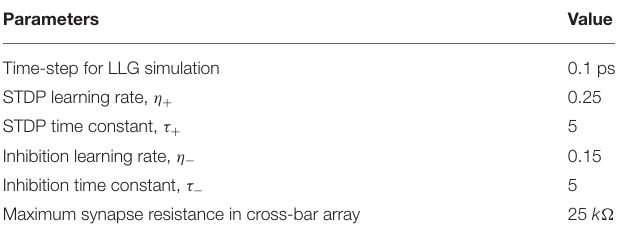
TABLE 2 | Learning simulation